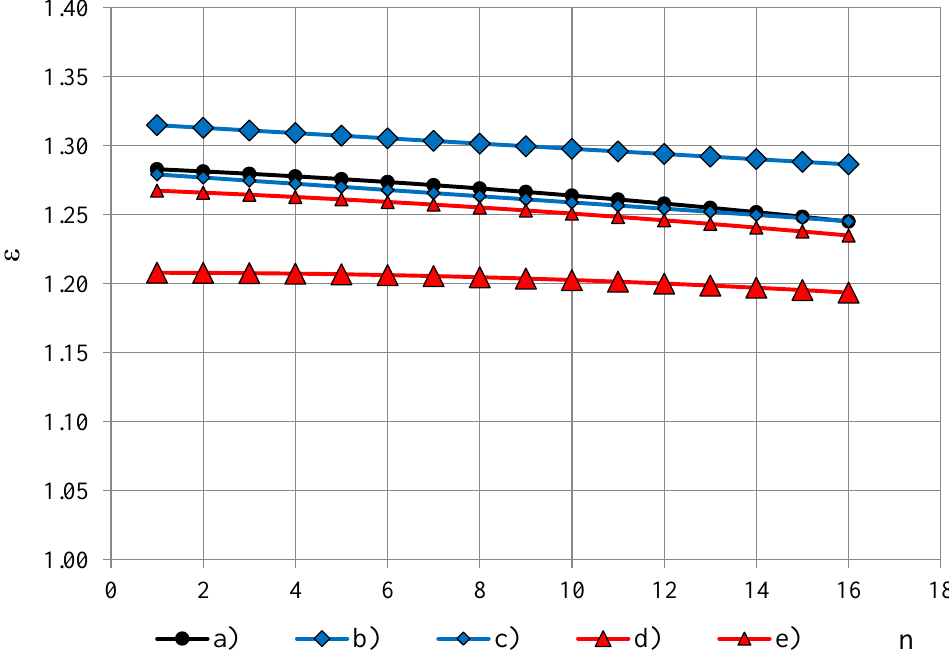
Figure 7. Permittivity spectra of PUR foams Sika-150, ρ = 144 kg/m 3 : (a) ε t , (b) ε T at PTFE film 0.20 mm, (c) ε T at PTFE film 0.04 mm, (d) ε T′ at PTFE film 0.20 mm and (e) ε T′ at PTFE film 0.04 mm.